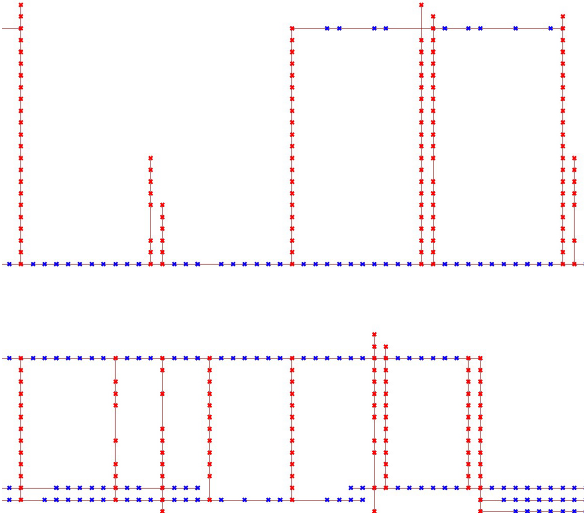
Figure 10 . Replacing double lines with an intermediate line (blue)